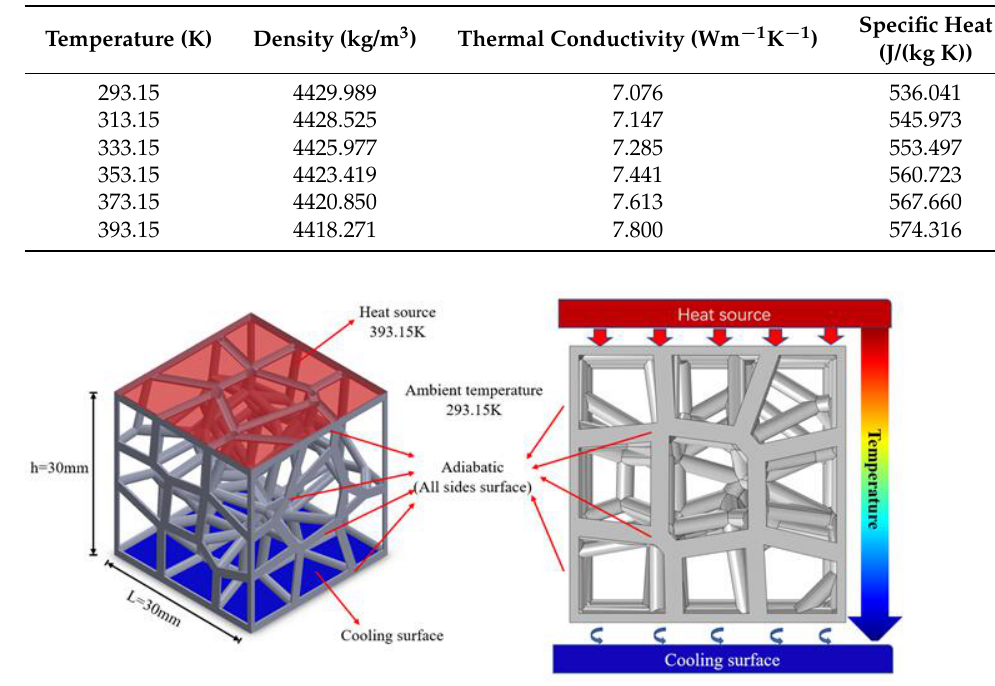
Table 3. Thermo-physical properties of Ti6Al4V alloy.